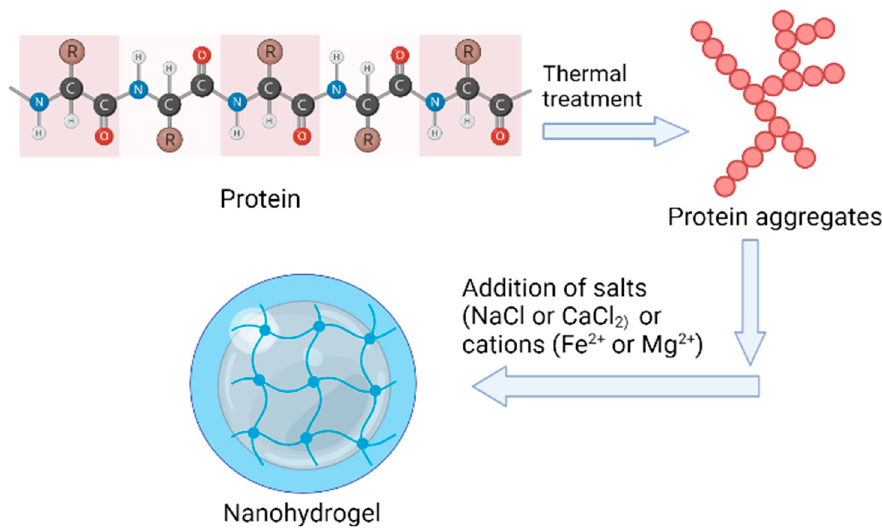
Figure 2. Schematic representation of synthesis of milk-protein-based nanohydrogel.